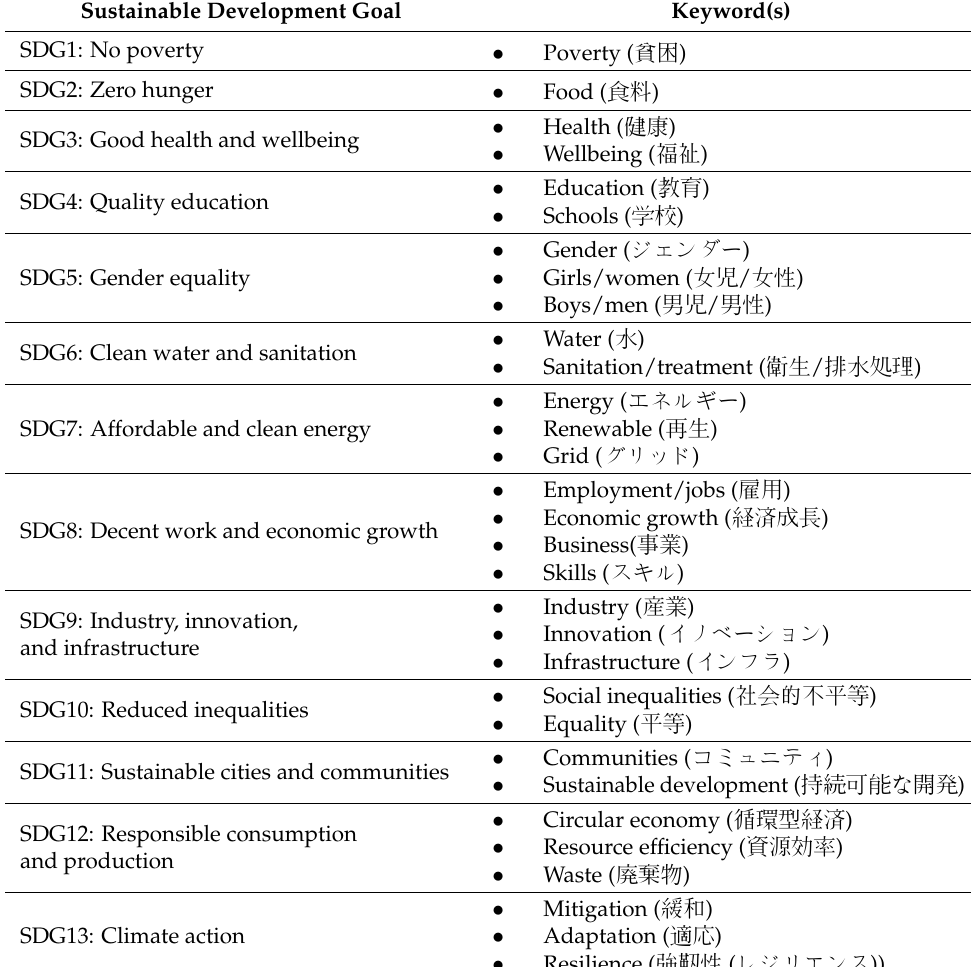
Table 1. Keywords used in the systematic text